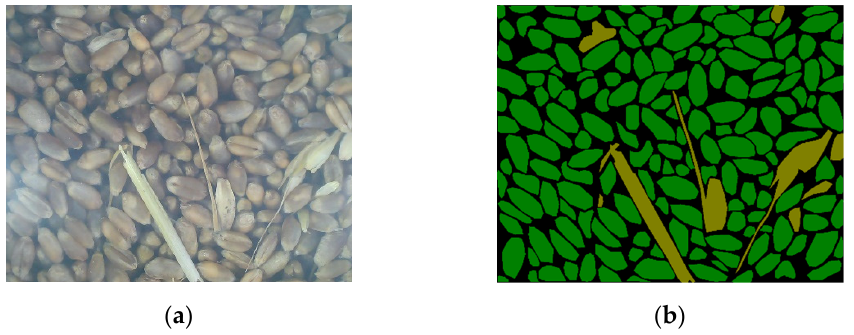
Figure 3. An example RGB image of wheat samples in the photo frame of the wheat mechanized harvesting online detection device ( a ) and the wheat sample labelled image with “polygons” ( b ). Black polygons, green polygons, and beige polygons represent areas marked as “background,” “grain,” and “impurity,” respectively.